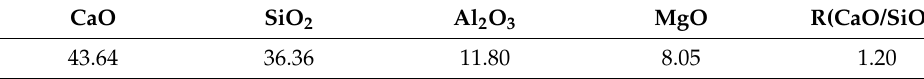
Table 2. Industrial analysis results of oily sludge.